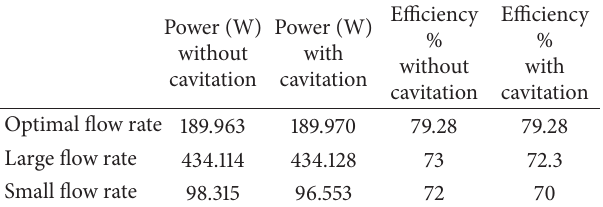
Figure 16: Cavitated vortex rope at large flow rate in the outlet of runner. Table 2: Prediction of produced power and efficiency.